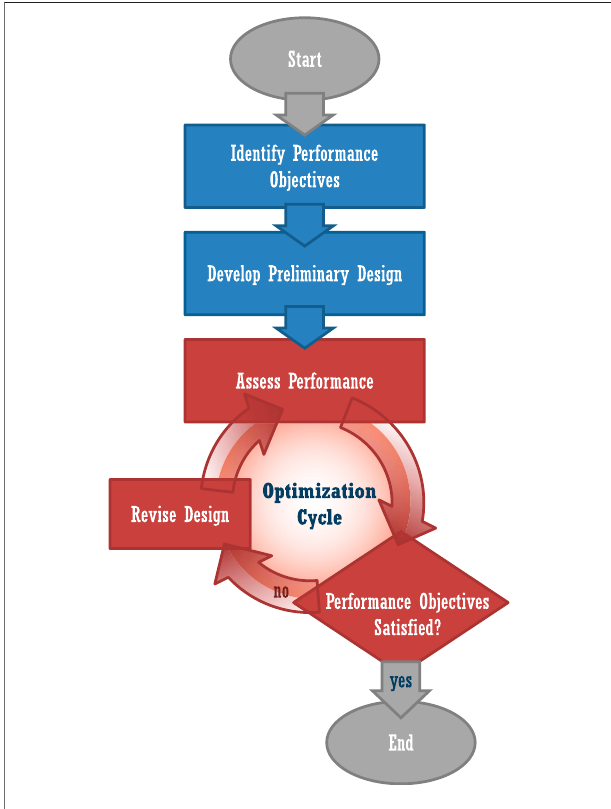
FIGURE 2 | The role of optimization in